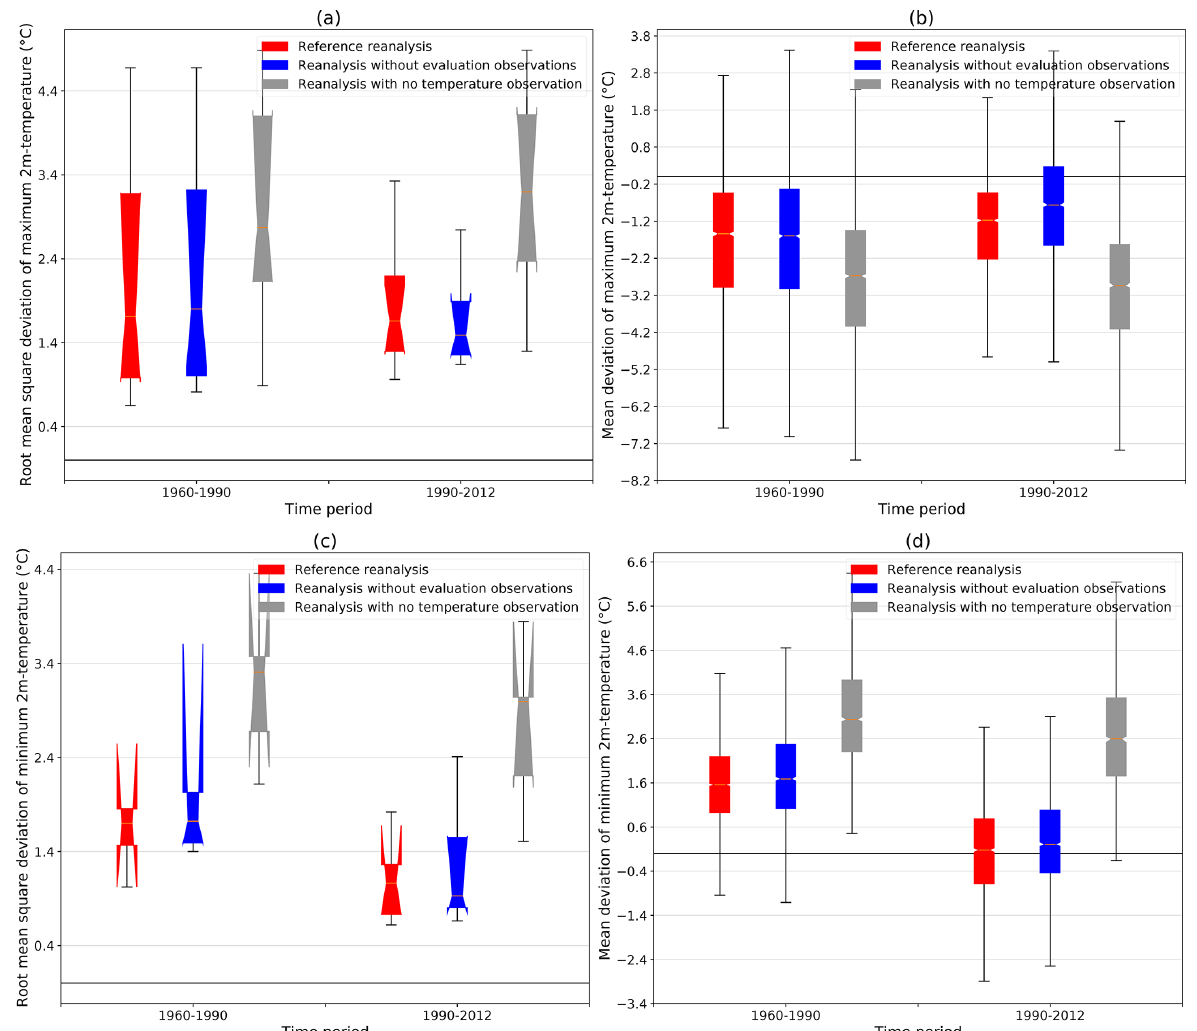
Figure 10. Root mean square deviation (a, c) and mean deviation (b, d) between the simulated monthly mean of maximum (a, b) and minimum (c, d) daily 2m temperatures and the corresponding homogenized series over the periods 1960–1990 and 1990–2012 for three different version of the S2M reanalysis (see Sect.